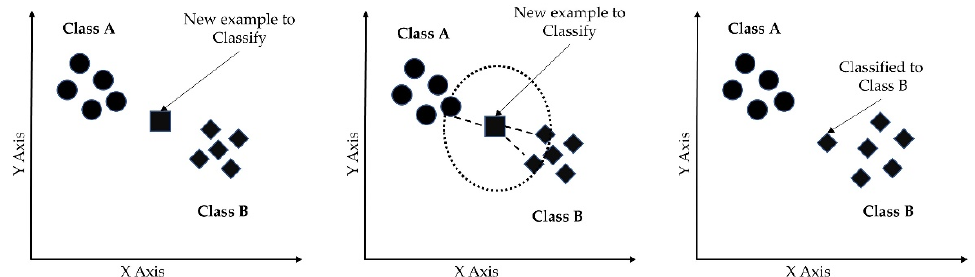
Figure 8. k -nearest neighbor algorithm for binary classification.